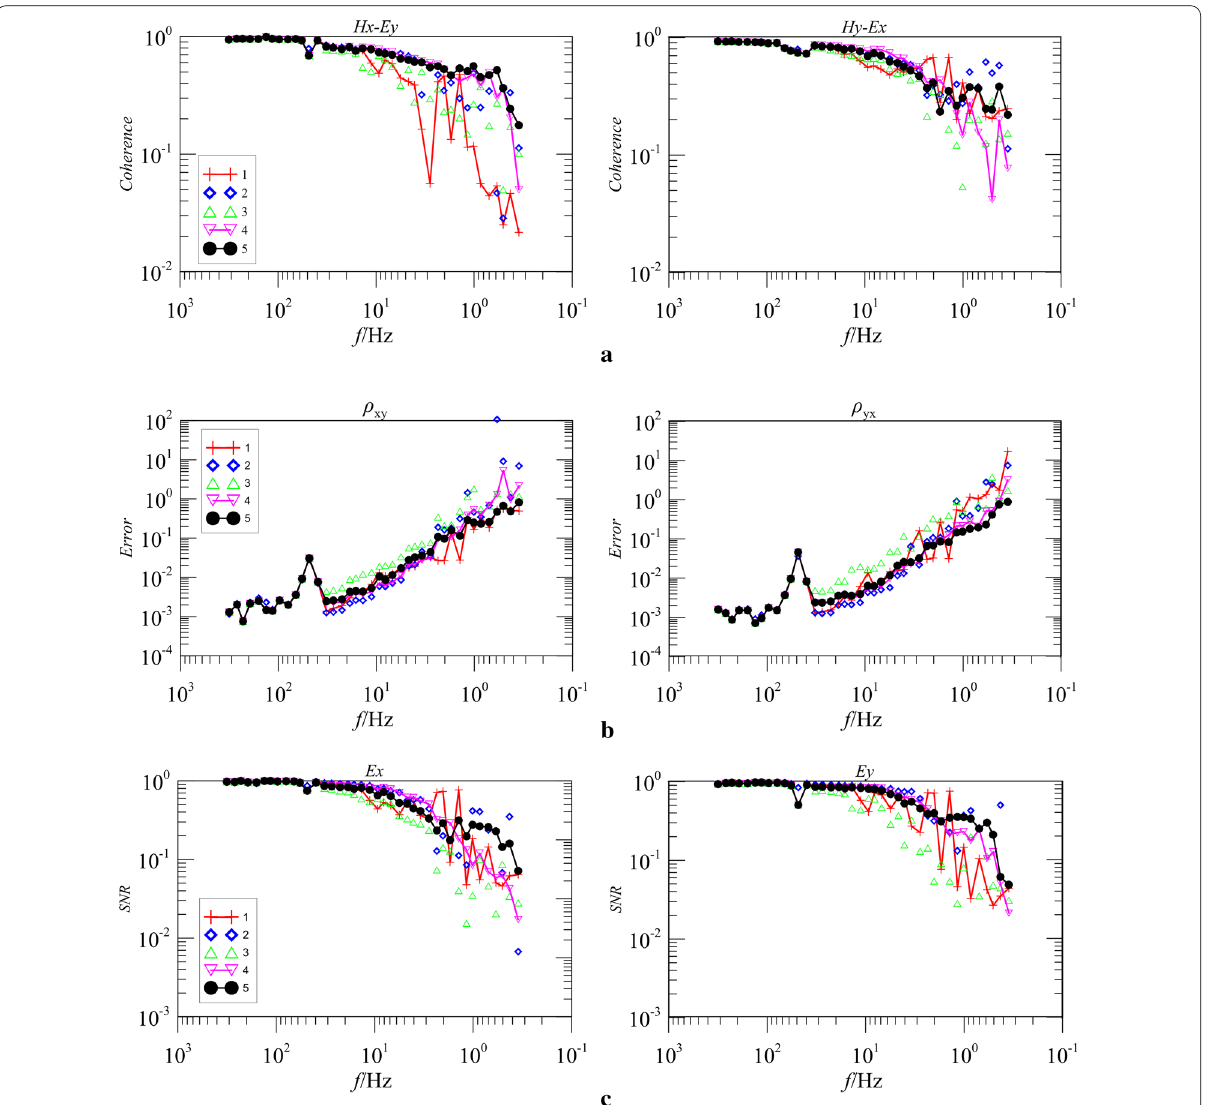
Fig. 9 Comparison of the coherence ( a ) error ( b ) and SNR ( c ) curves for site EL22174. Among them, curve 1 is the original data, curve 2 is the result obtained by the RR method, curve 3 is the data filtered by the OMP-based overall method, curve 4 is the result derived from the fractal-entropy and clustering method, and curve 5 is the result derived from the proposed